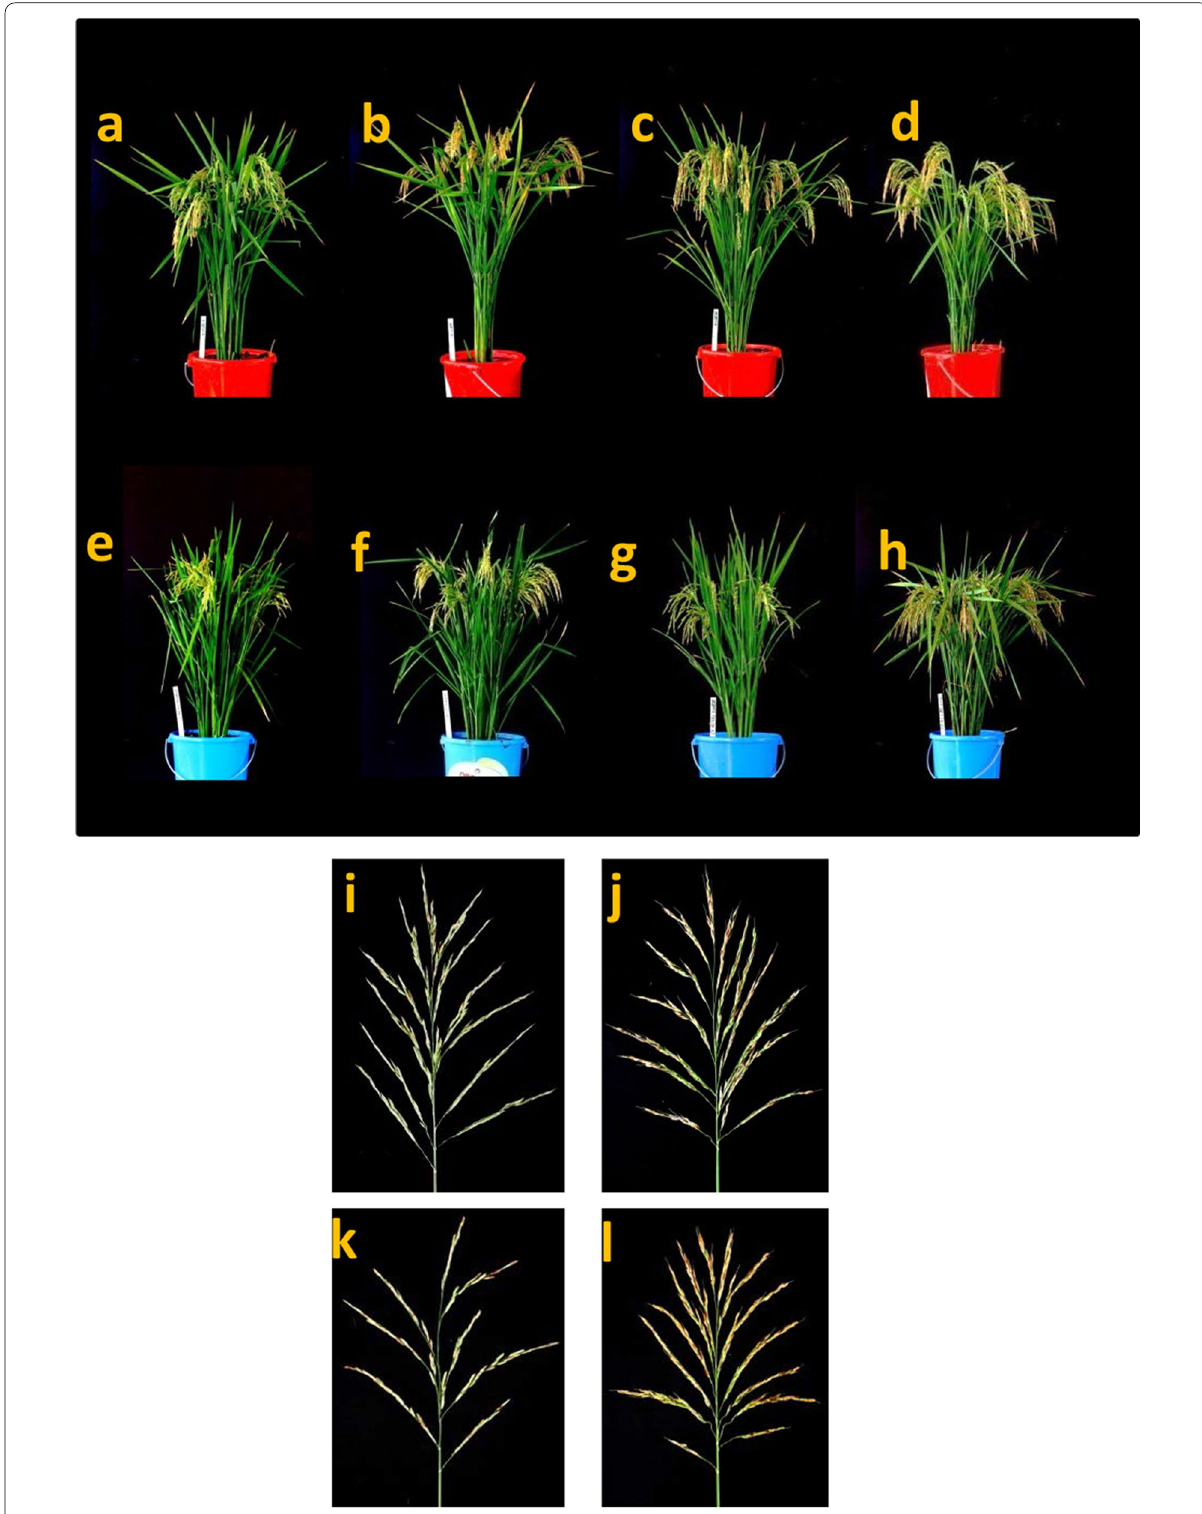
Fig. 5 Photographs showing the plant architecture of a IR58025B, b 91B‑42, c IR68897B, and d 107B‑12 maintainer lines and e IR58025A, f 91A‑18, g IR68897A, h and 107A‑35A CMS lines and seed setting in the panicle of i IR58025A, j 91A‑18, k IR68897A, and l